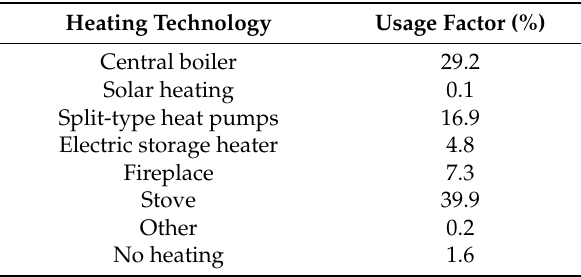
Table 2. Use of heating technologies in the current building stock of Cyprus